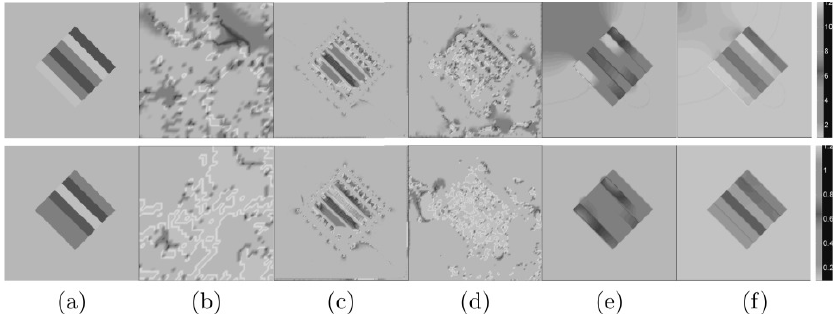
Figure 5. Case 2: Simulation results for µ (first row) and η µ (second row) image reconstruction. (a) True images; (c) direct inversion method; (e) hybrid one-step method; (b), (d) and (f) are reconstructed images by the adjoint-based optimization method (2.13) with initial guess of the constant µ 0 + iωη µ , (c) and (e), respectively. 0